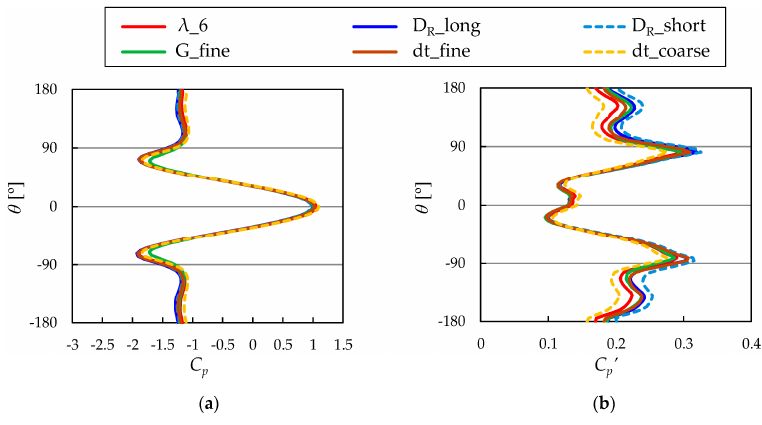
Figure 6. Sensitivity of D R , the grid resolution around the tower, and dt on distributions of the mean and fluctuating pressure coefficients on the tower surface at the mid-height of Segment 6 at λ = 6. ( a ) Mean pressure coefficient; and ( b ) fluctuating pressure coefficient.